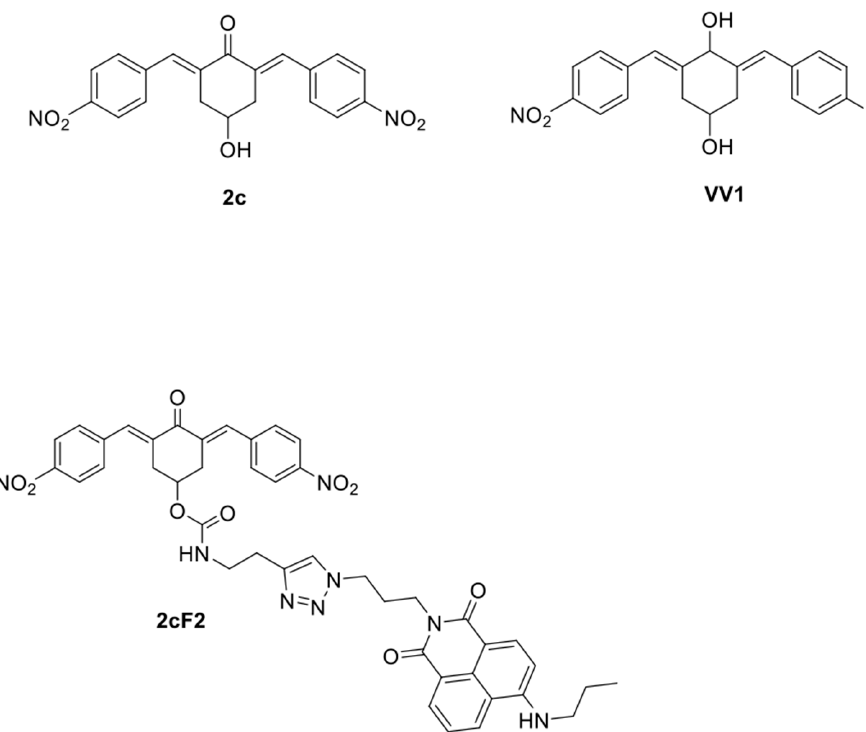
Figure A3. Structure of 2c and its derivatives used in the present study, namely VV1 the inactive form used as negative control and 2cF2, the 2c labeled with the fluorophore 4 ‐ propylamino ‐ N ‐ allyl ‐ 1,8 ‐ naphthalimide used in the uptake analysis.